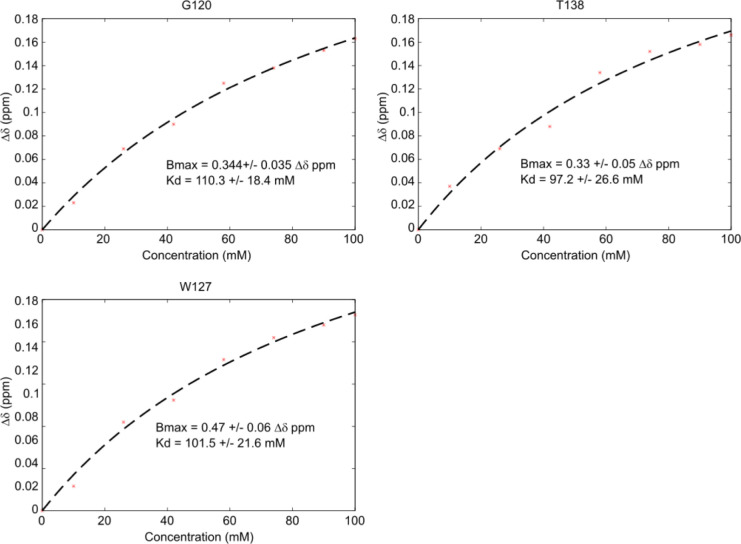
Kd estimation from HSQC titration data.Kd estimation was performed using the sum of the average chemical shift distance plotted against ligand concentration and fit using a standard ligand binding curve. Representative fits for G120, W127, and T138 are shown with corresponding estimations for Bmax, the maximum Δδppm, and Kd highlighted.